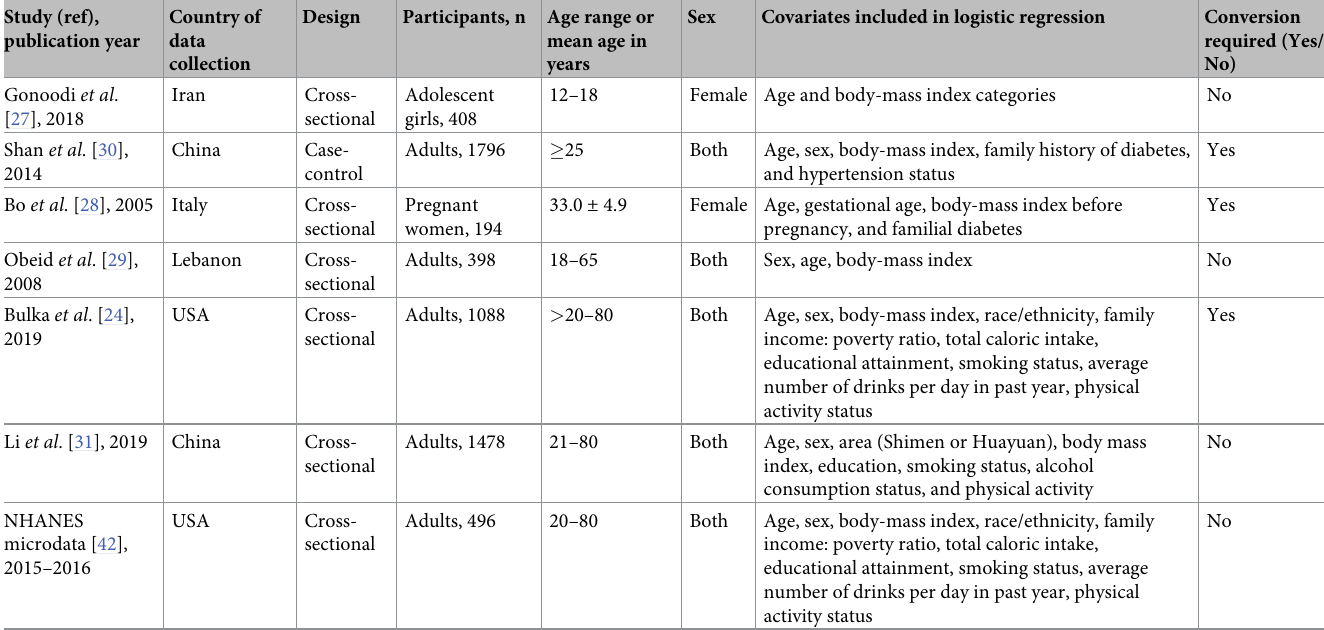
Table 1. Characteristics of included studies included in Zn-FBG meta-analysis.